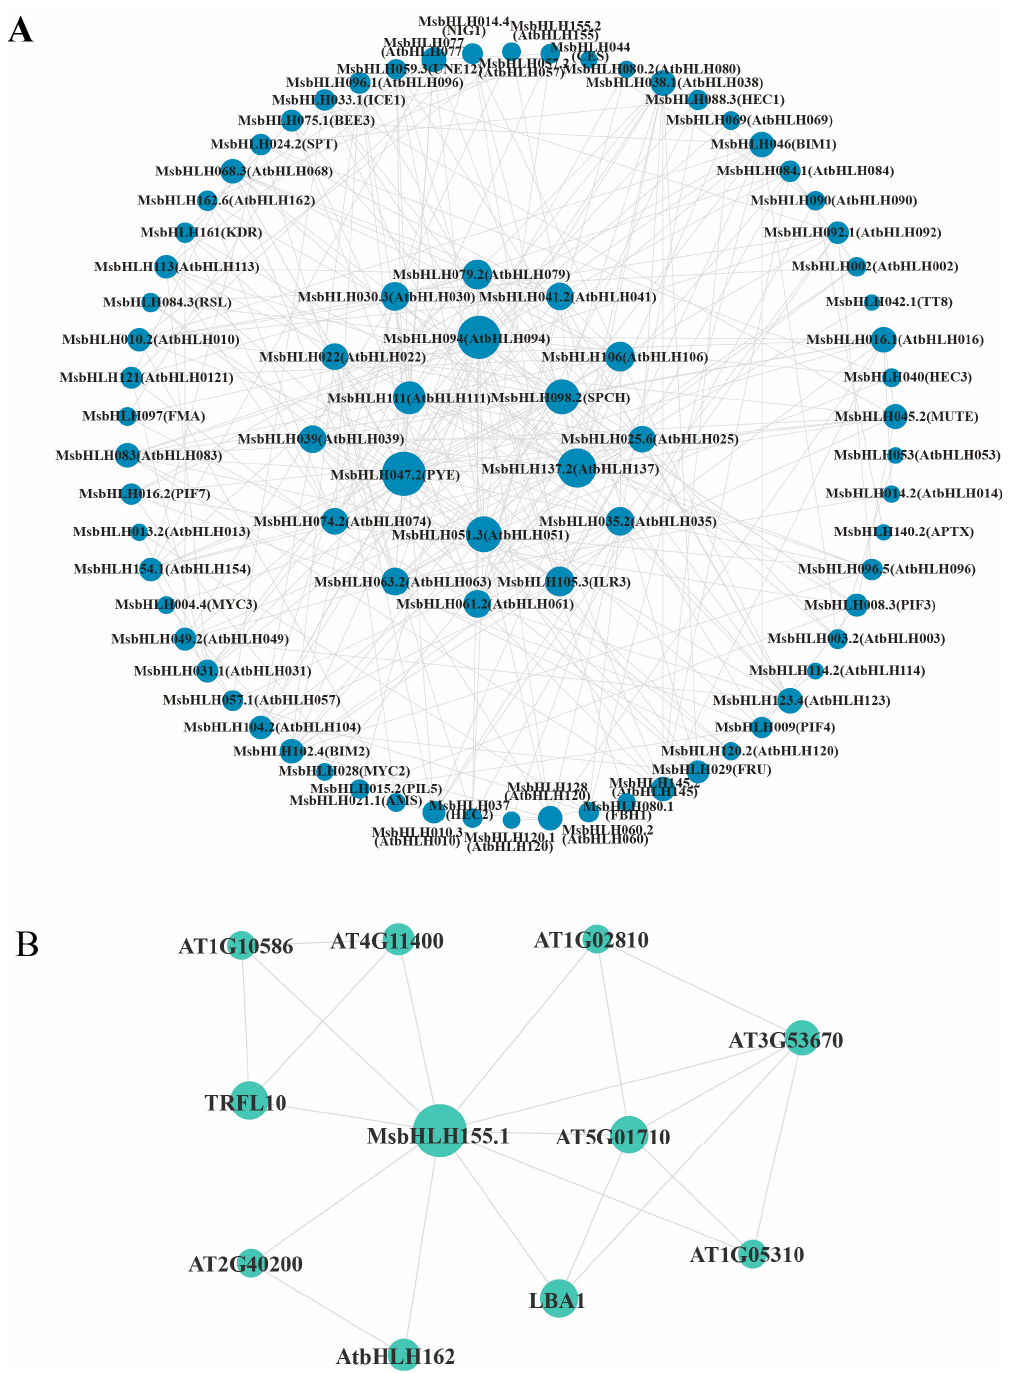
Figure 6. bHLH protein interaction network of M. sieversii based on their orthologs in Arabidopsis . ( A ) STRING website was used to predict the bHLH protein interaction network of M. sieversii . The A. thaliana was chosen as the reference plant, and then the minimum required interaction score (0.4000) was set to middle confidence. ( B ) Protein interaction network of MsbHLH155.1 .